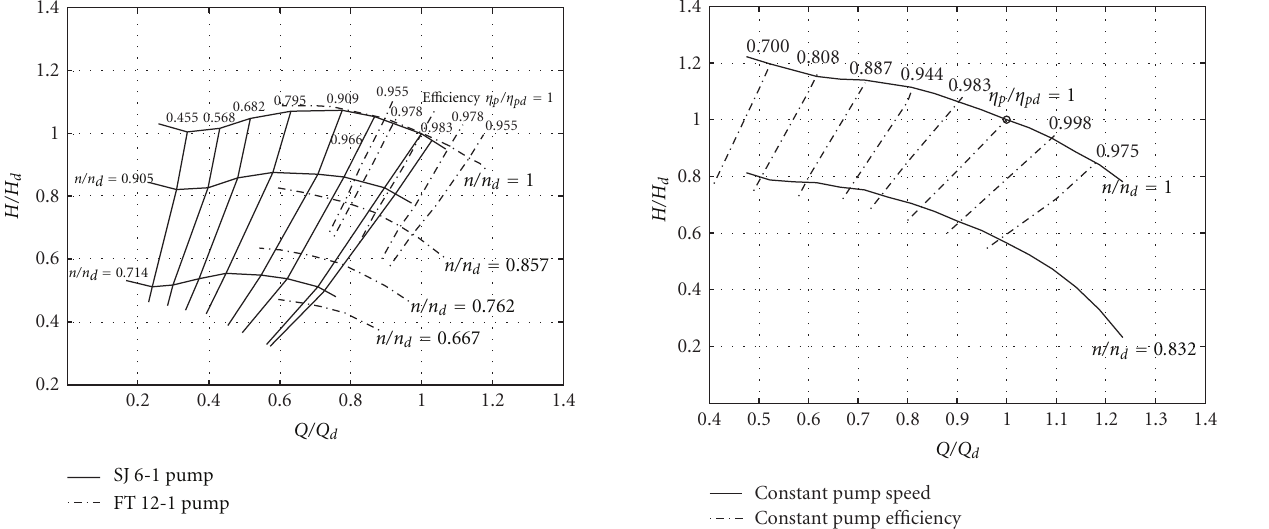
Figure 6: “Termomeccanica C 1PPA 155” pump performance map.